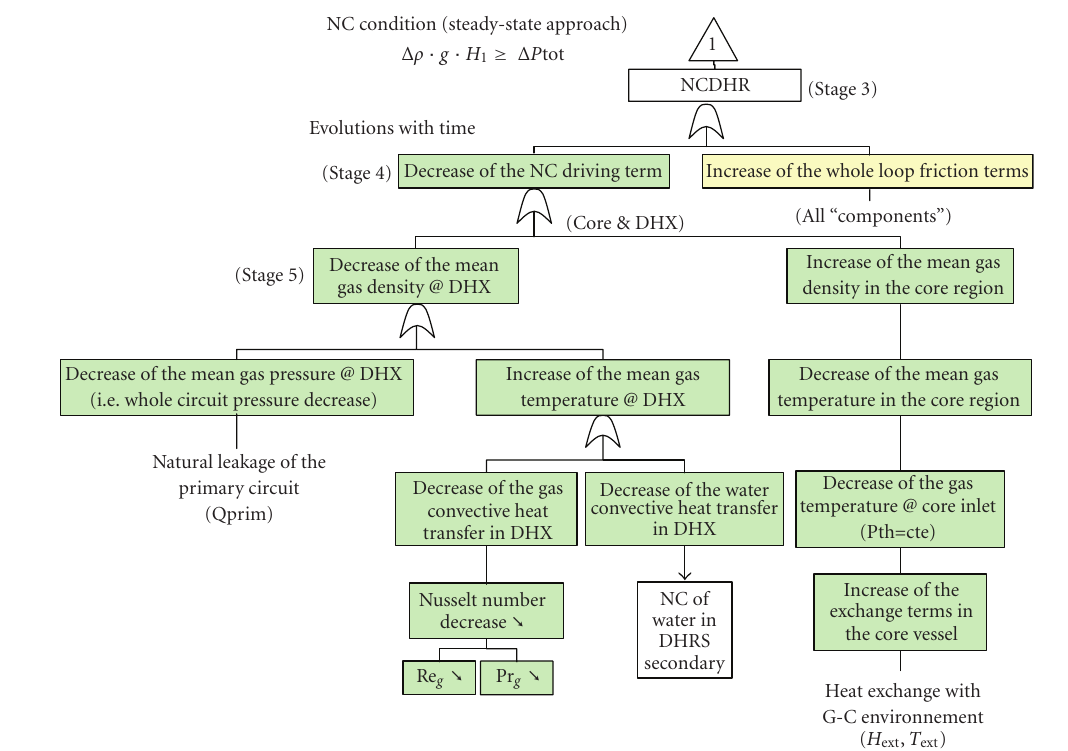
Figure 9: Development of the deductive approach for critical parameters determination (NCDHR pressure drops “1”).